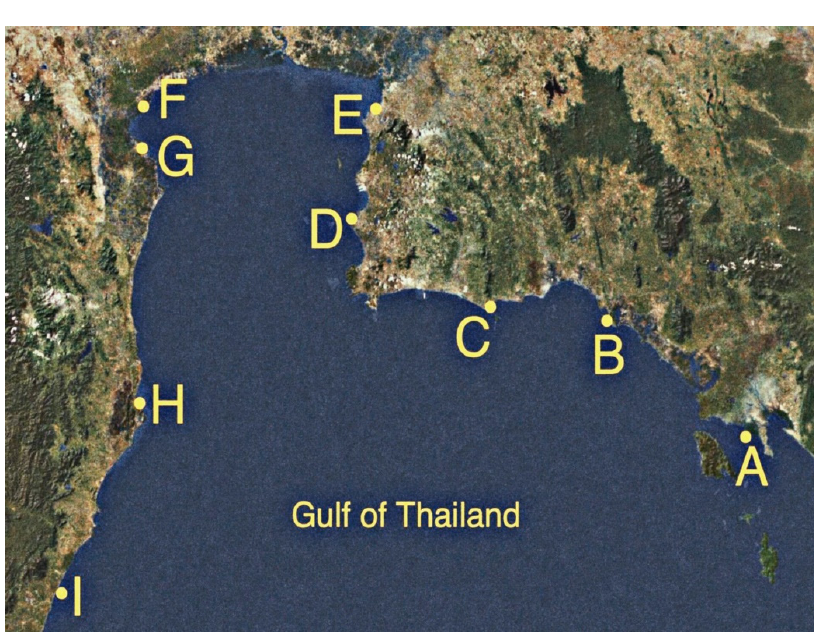
Figure 1 . Nine sampling sites along the shores of the Upper Gulf of Thailand . Site A, Black Sand Figure 1. Nine sampling sites along the shores of the Upper Gulf of Thailand. Site A, Black Sand Beach; B, Kungkrabaen Bay; C, Suanson Beach; D, Pattaya Beach; E, Angsila old market; F, Don- hoylhod; G, Bangtaboon Bay; H, Pranburi forest park; I, Wanakorn Beach .